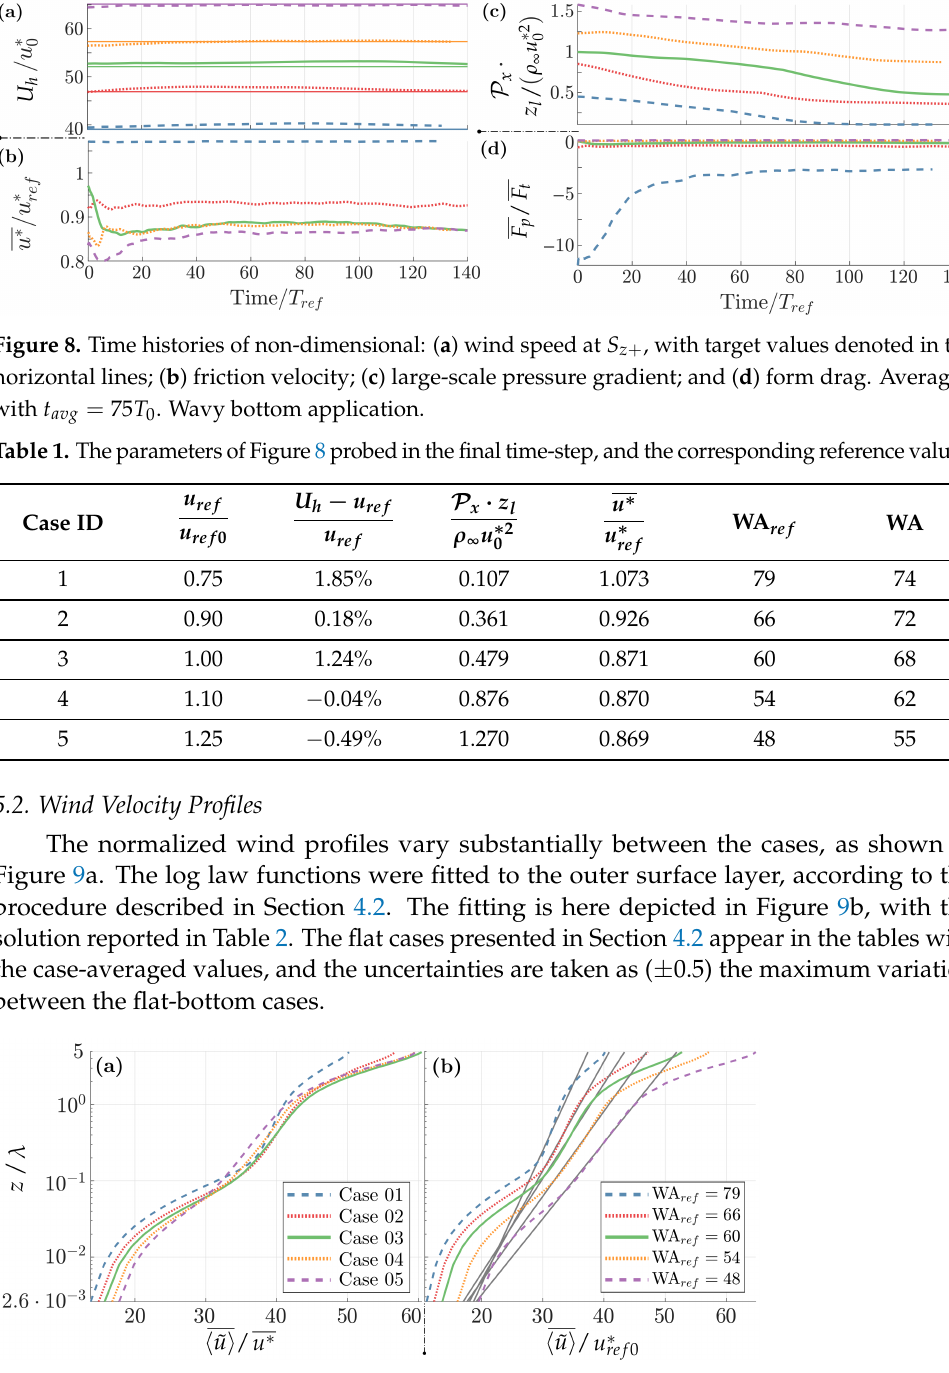
Figure 9. Longitudinal velocity profiles averaged with t avg = 75 T 0 . ( a ) Normalized by the resolved friction velocity. ( b ) Normalized by the reference friction velocity; with logarithmic profiles fitted to the outer region, depicted in black transparent